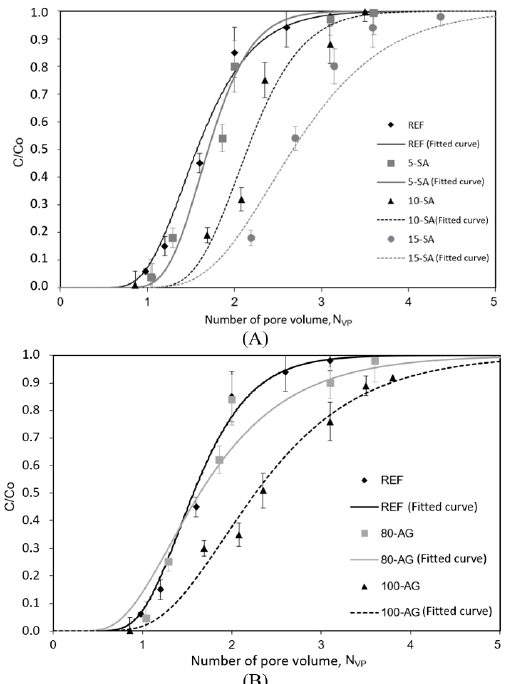
Figure 11. Relative chloride concentration curve in the concrete column test with different content of (A) silica fume and (B)